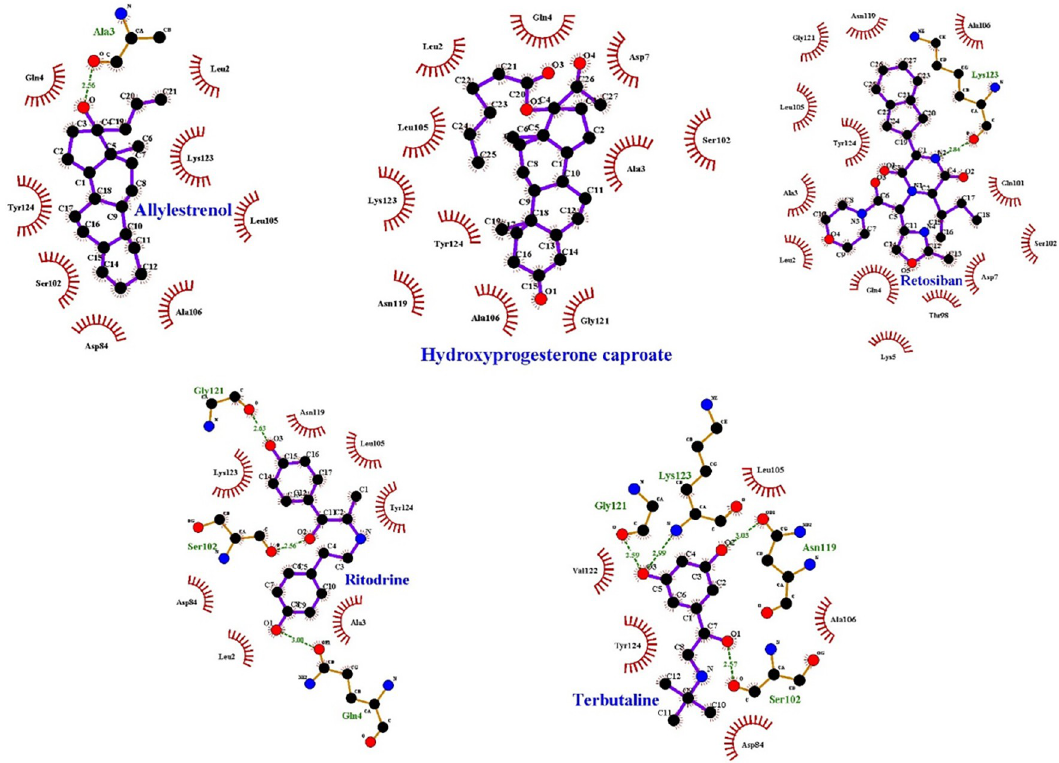
Fig 6. 2D Ligplot showing molecular docking interactions of CNN1 isoform 2 with PTB-drugs. Protein-ligand based graphical depiction showing the potential interacting residues of CNN1 protein with Allylestrenol, Hydroxyprogesterone caproate, Retosiban, Ritodrine and